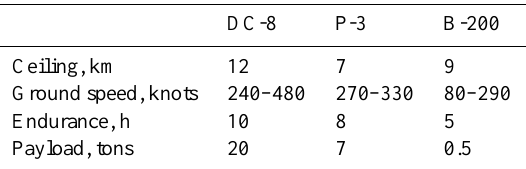
Table 2. Operational characteristics of the ARCTAS